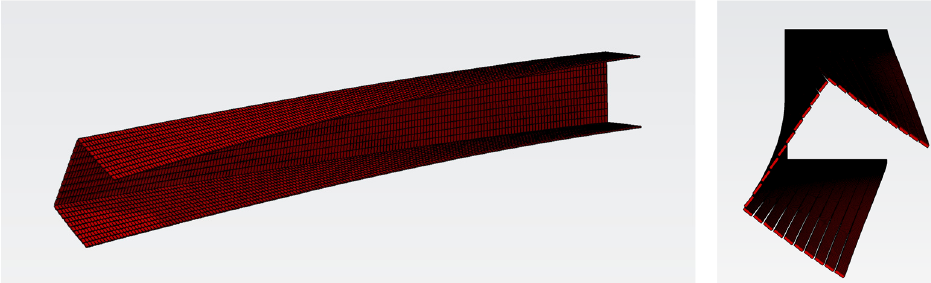
Figure 3. Deformation of the beam element under shear force with the AEM model (longitudinal discretisation equal to 180 and transversal discretisation of 10). It can be noted the typical coupled flexural–torsional behaviour.